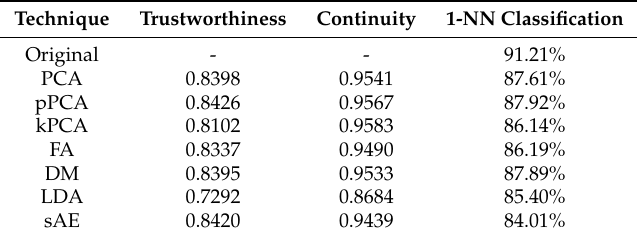
Table 2. Trustworthiness and continuity scores for the different dimensionality reduction techniques (higher values are better) and classification accuracy of 1-NN